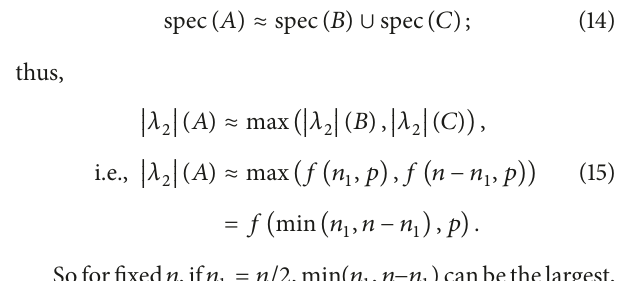
Figure 4: The relationship between the size of subgroups and the second largest eigenvalue modulus. 𝑥 -axis is the size of one subgroup and 𝑦 -axis is the second largest eigenvalue modulus. Here we assume the size of 𝐺 is 150, 𝑝 in (c), 𝑝 1 = 0.4 , 𝑝 2 = 0.2